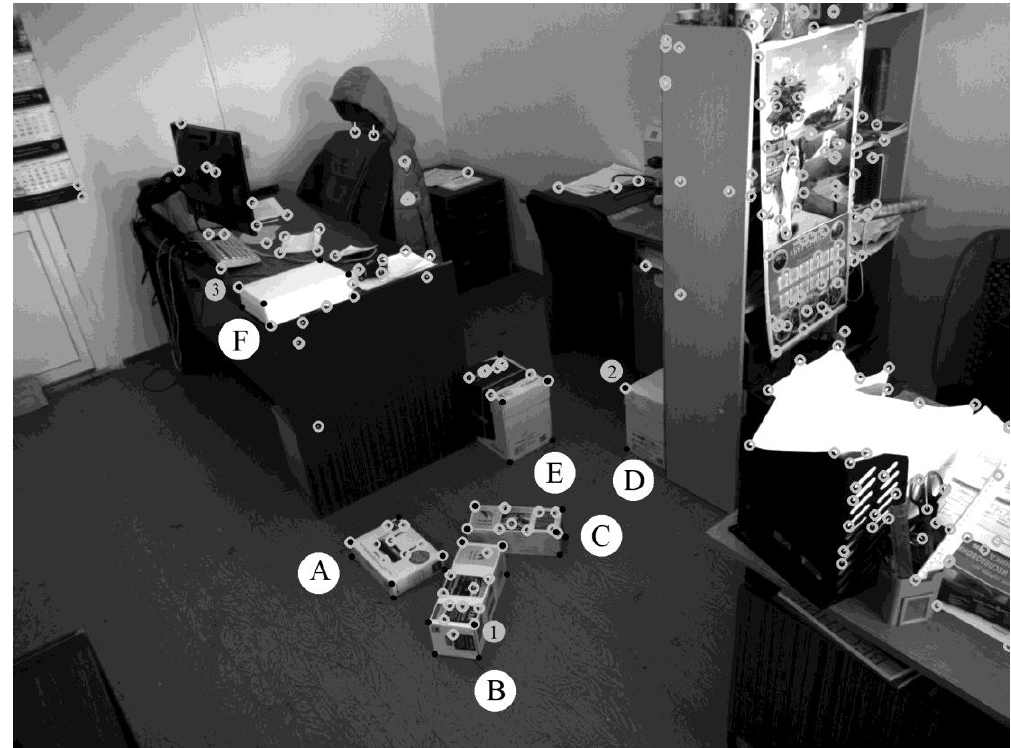
Figure 8. In the photo taken by the Karmin2 camera, the desired objects are marked: A–F. Points belonging to the desired objects (model) are marked in black. Their number is 48, as indicated by the operator showing eight on each box. Of these, 33 points fell into the camera's field of view: on object A—7, on B—7, on C—6, on D—2, on E—4, on F—7. The coordinate system (CS), in which all points of objects (model) were set, was built on three corner points of object A. The points built by the Harris detector are marked with white circles. There are 89 of them in the scene.